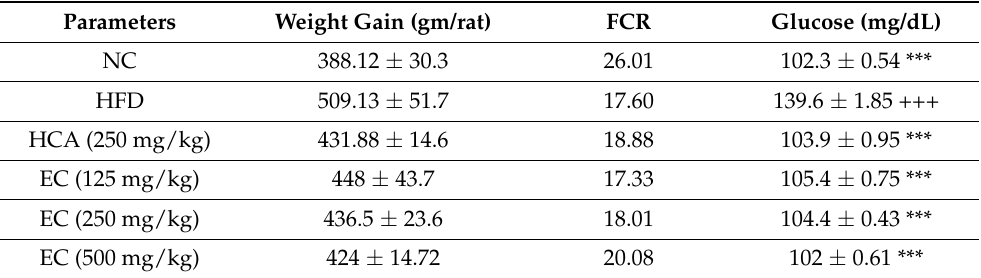
Figure 4. The effects of Ecklonia cava ethanol (70%) extract (ECE) on body weight ( A ), average feed intake ( B ), spleen ( C ), liver ( D ), and kidney ( E ) weights in high-fat diet-fed SD rats for 8 weeks. Data are presented as means ± SEM ( n = 8 for each group). Values with different letters present significant differences ( p < 0.05). Table 2. Effects of Ecklonia cava ethanol (70%) extract on weight gain, % weight gain compared to HFD group, feed intake, feed conversion ratio, and blood glucose (g/dL).